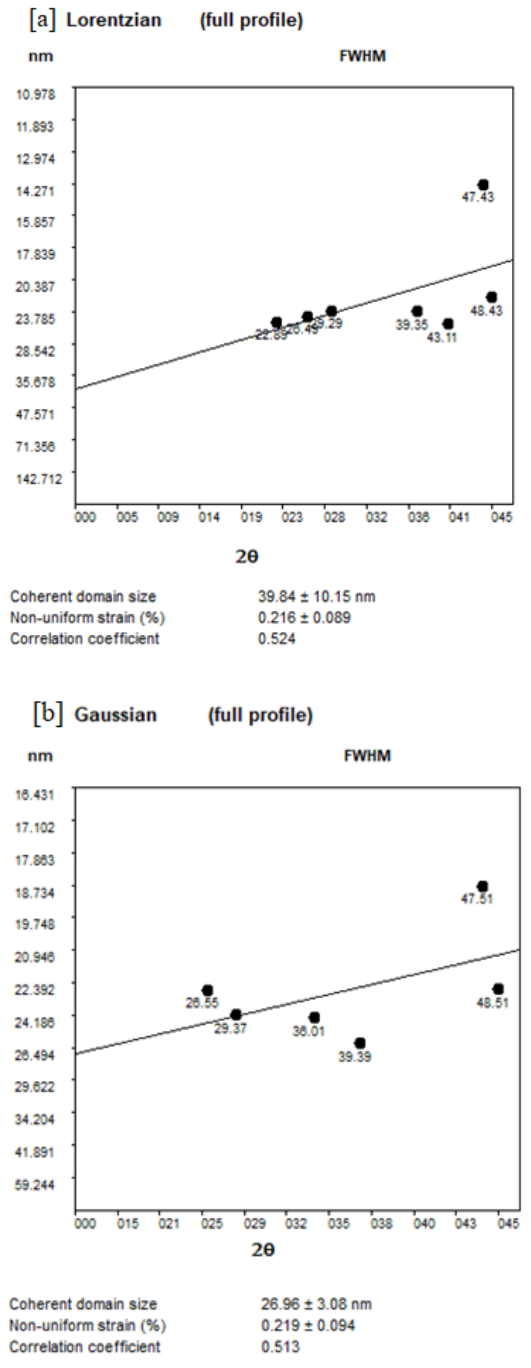
Figure 2. The particle size of ( a ) calcinated bentonite and ( b ) ball-milled bentonite by Williamson–Hall size analysis.